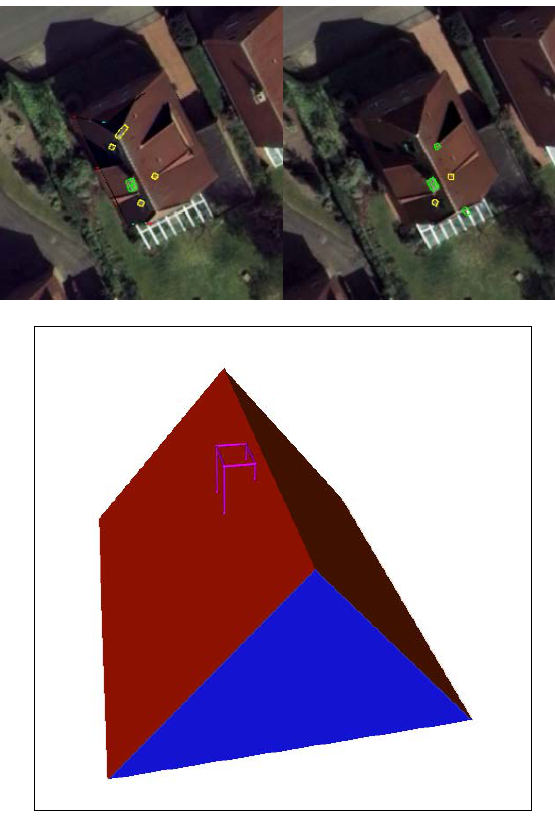
Figure 5. Steps within Extraction of chimneys. Top: Processed building in one perspective and the extracted chimney candidates (green: good candidates). Bottom: The selected and extrudes chimney.